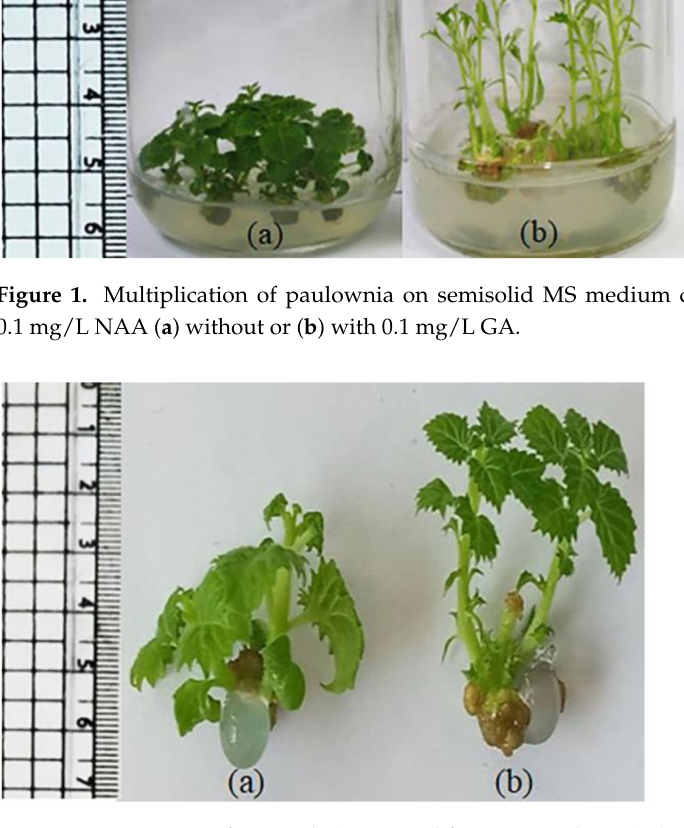
Figure 2. Conversion of synseeds (conserved for one month at 4 ◦ C) on semisolid MS medium with 2 mg/L BAP and 0.1 mg/L NAA for one month. Encapsulated nodal explants were obtained from in vitro shoots grown on MS medium containing 2 mg/L BAP and 0.1 mg/L NAA ( a ) without or ( b ) with 0.1 mg/L